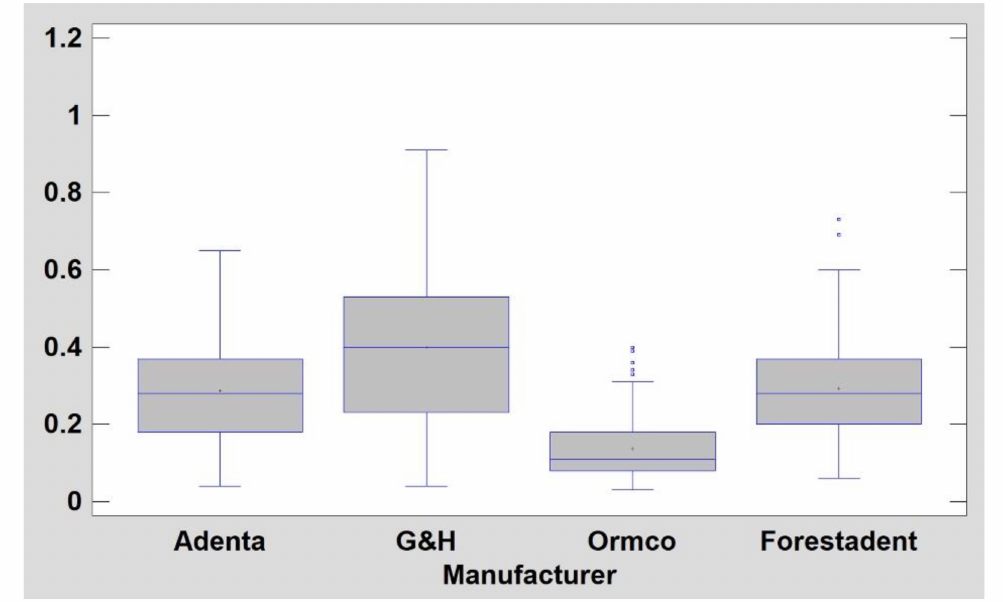
Figure 5. Stainless steel archwire comparison (mean side 1 and side 2 texture index, TI; higher TI means better result). There are significant differences between product groups in the arrangement of texture made up of bright areas (i.e., low-friction surfaces). The best surface is represented by G&H ( p < 0.05). Slightly worse surfaces for Adenta and Forestadent, which in turn have a significantly higher TI than the Ormco product ( p < 0.05), y axis indicates values of texture